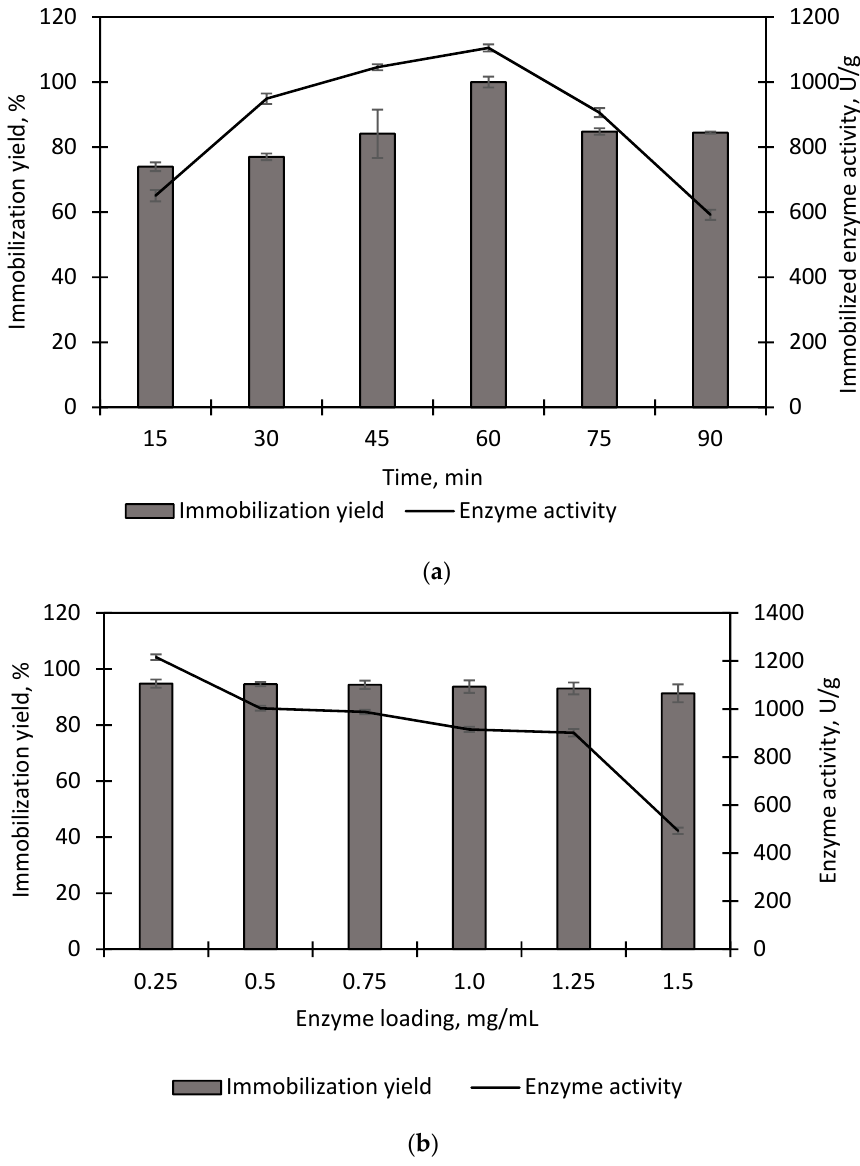
Figure 2. ( a ) Time course for EstD9 adsorption profile onto Seplite LX120; ( b ) effect of enzyme loading during immobilization procedure.